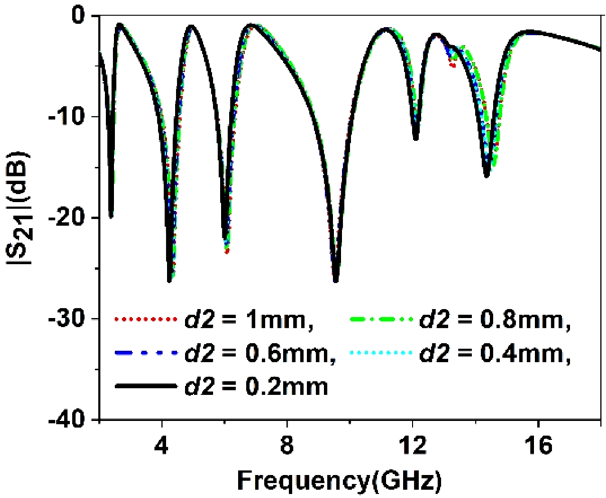
Figure 10. Study of variation of |S 21 | with second outer ring split gap, d2.